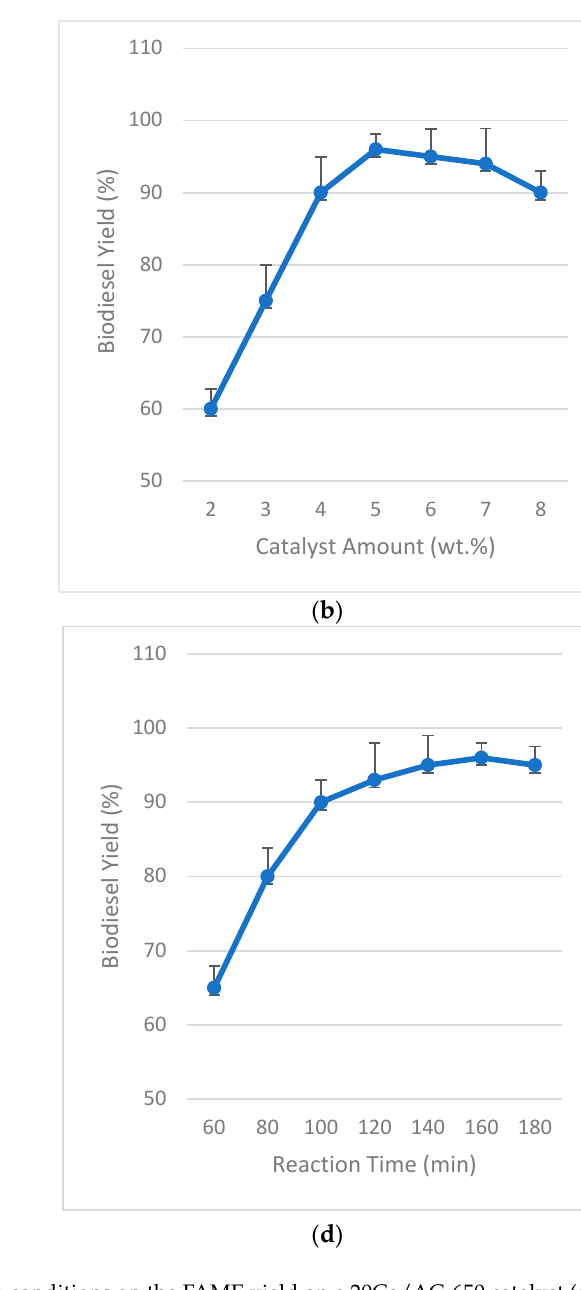
Figure 4. Influence of reaction conditions on the FAME yield on a 20Ca/AC-650 catalyst (all reactions carried out at optimum conditions, i.e., an oil-to-methanol molar ratio of 1:8, catalyst amount 5 wt.%, reaction temperature 65 °C, and reaction time 160 min) ( a ) Oil to methanol molar ratio, ( b ) Catalyst amount, ( c ) Reaction temperature and ( d ) Reaction time.